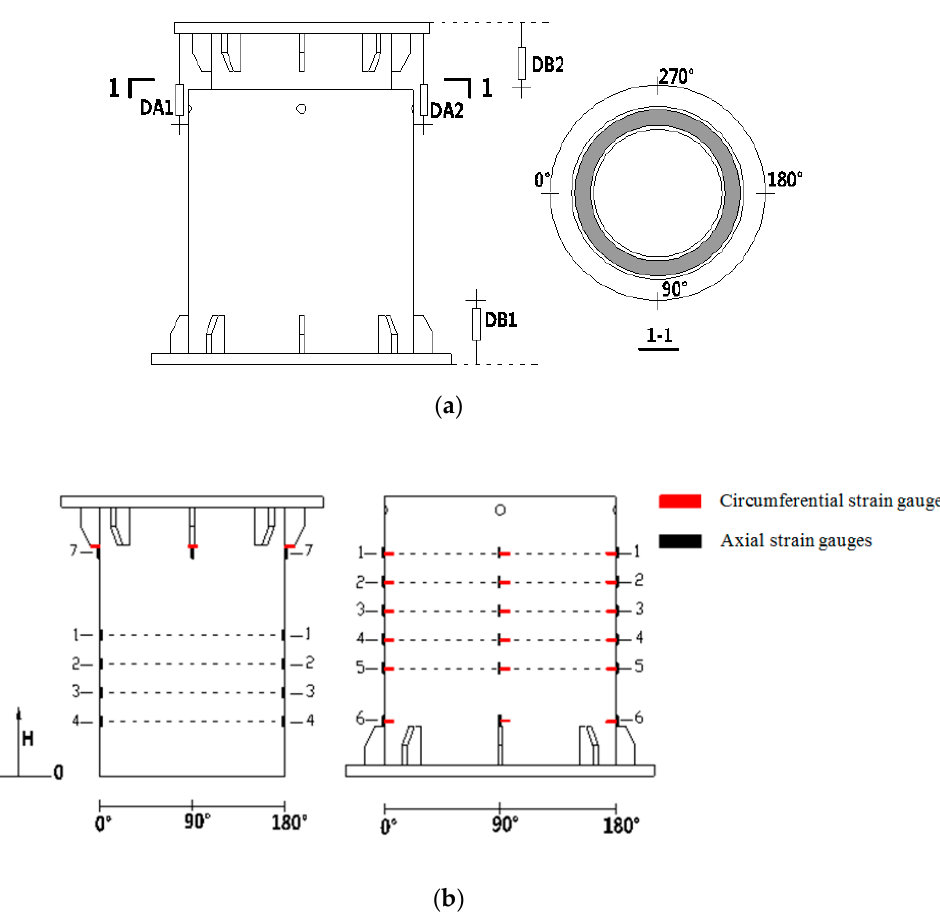
Figure 10. Arrangement of ( a ) displacement transducers (DTs) and ( b ) strain gauges on specimens.